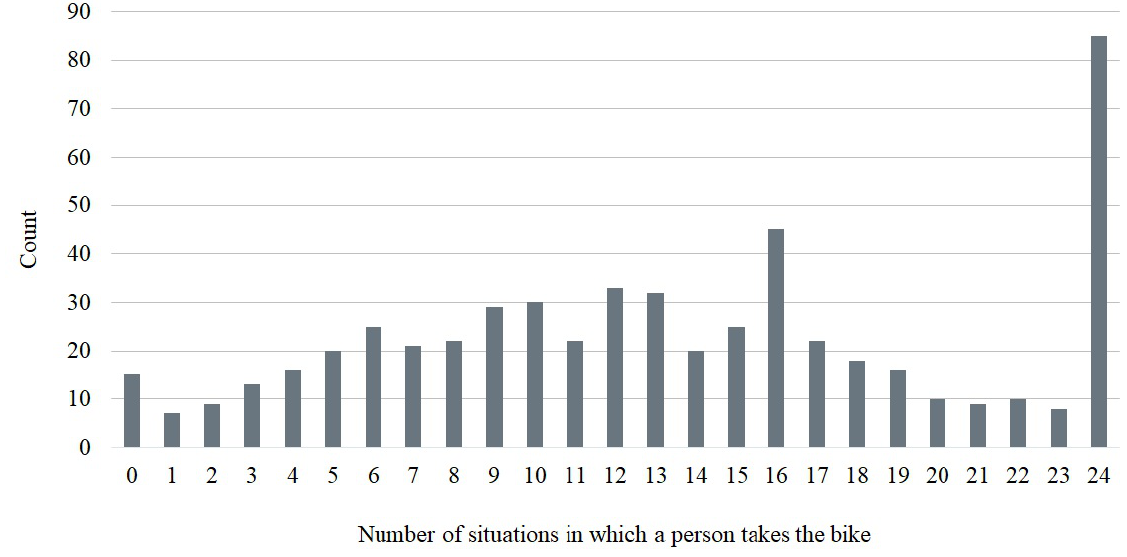
Figure 2. Number of people who chose the bike in a certain number of situations. The response